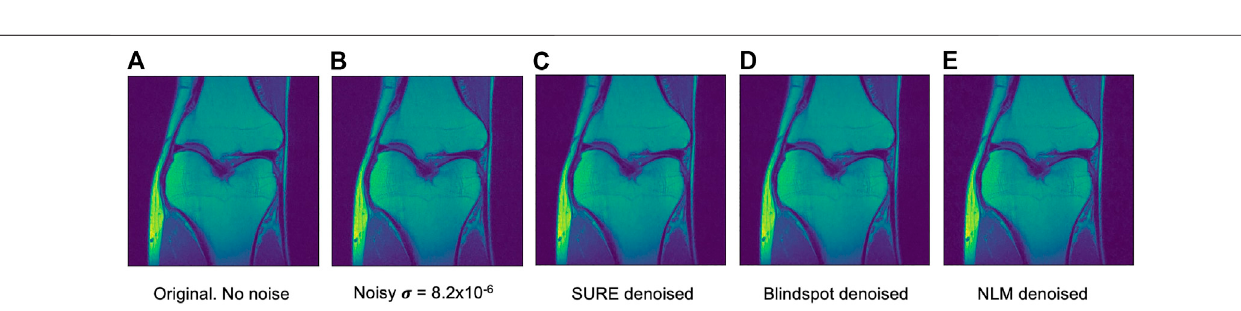
FIGURE 4 | Example of denoised knee MRI for σ (cid:1) 8 . 2 × 10 − 6 . The example image is the middle slice from one of the subjects. In this case, this is the PSNR for every method for this particular subject. (A) Original image, no noise added — (B) Noisy image — (C) SURE PSNR (cid:1) 37.092 — (D) Blindspot PSNR (cid:1) 37.317 — (E) NLM PSNR (cid:1)